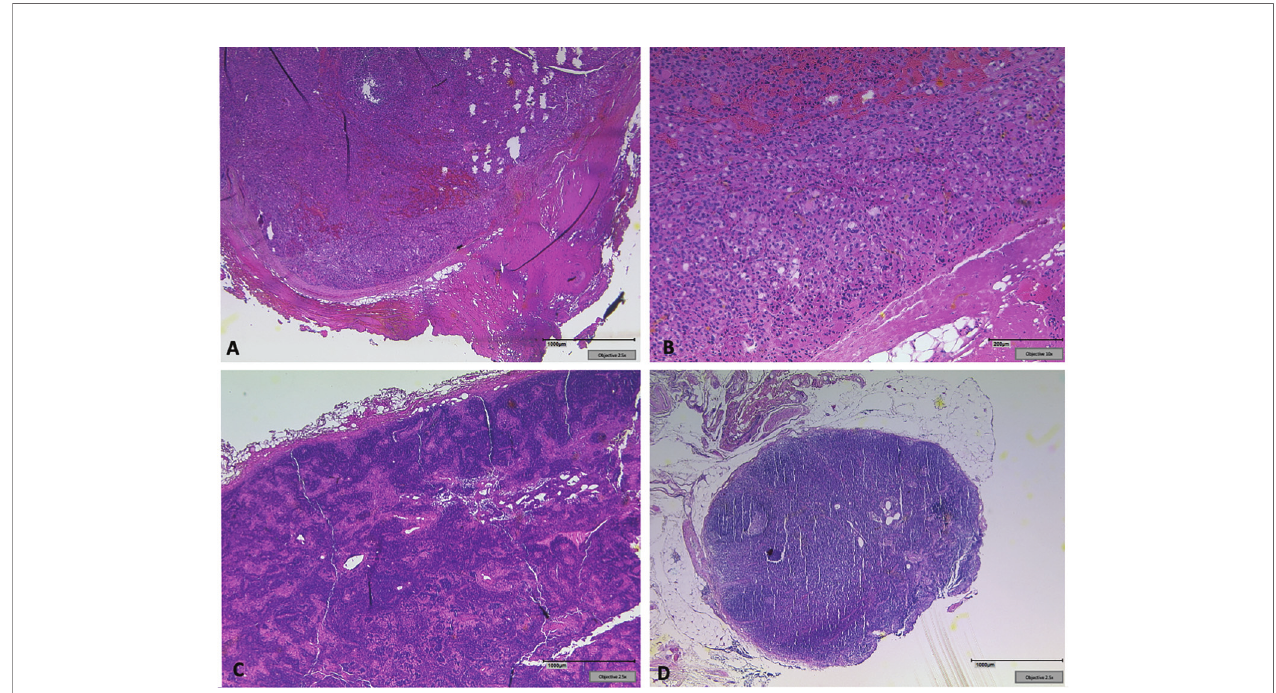
FIGURE 2 | (A) Soft tissue implant showing a well-circumscribed tumor nodule partially surrounded by a fi brous capsule clinically mimicking lymph node metastasis. (B) Oncocytic tumor cells form small follicles, sharply separated from surrounding soft tissue. No lymphatic tissue detectable. (C) Tumor free lymph node next to the left jugular vein. (D) Exemplary clear lymph node from the central compartment in the same